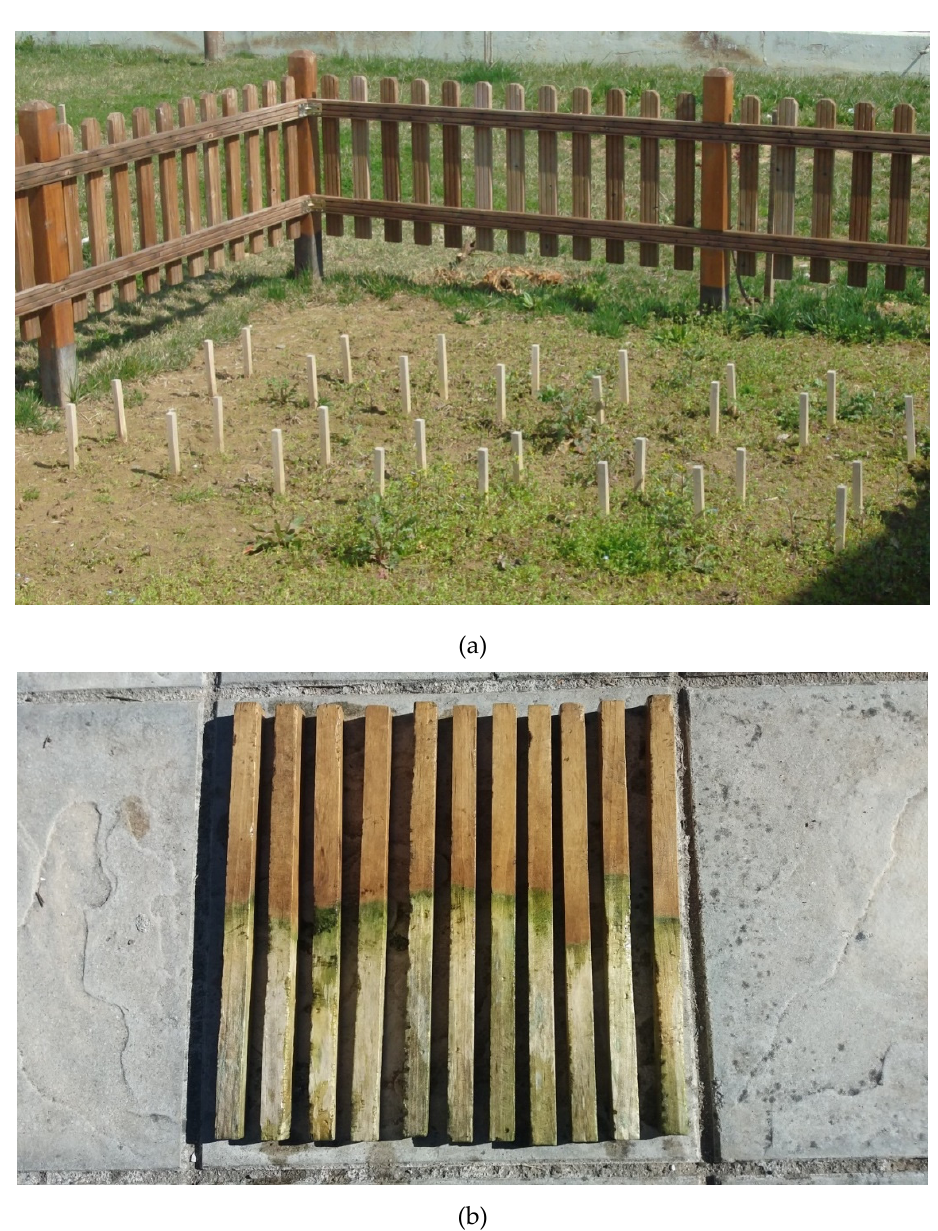
Figure 2. Soil test area used in the experiment ( a ), Accoya stakes as removed after 10 years of ground stake testing in Karditsa, Greece ( b ).